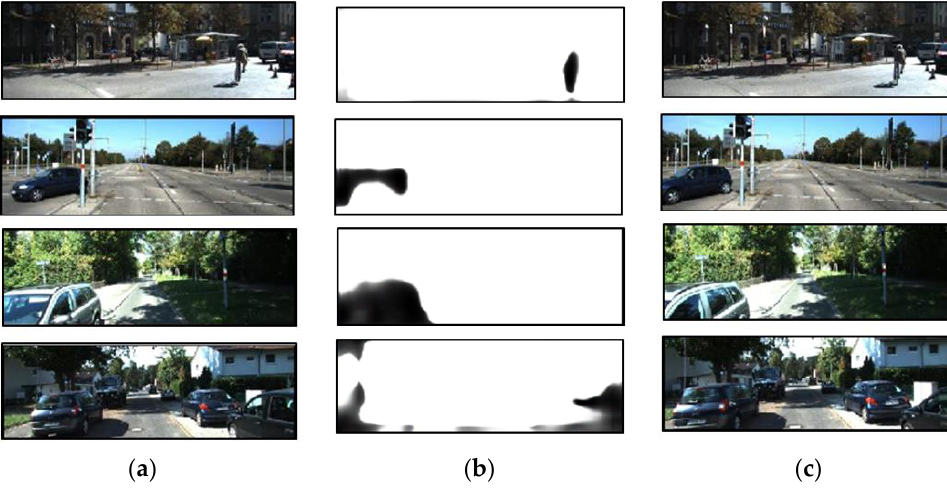
Figure 14. Visualization of confidence masks. The black area in ( b ) denotes occlusion, motion or missing pixels in the reprojection process of two adjacent frames. ( a ) I t−1 ( b ) confidence mask ( c ) I t .